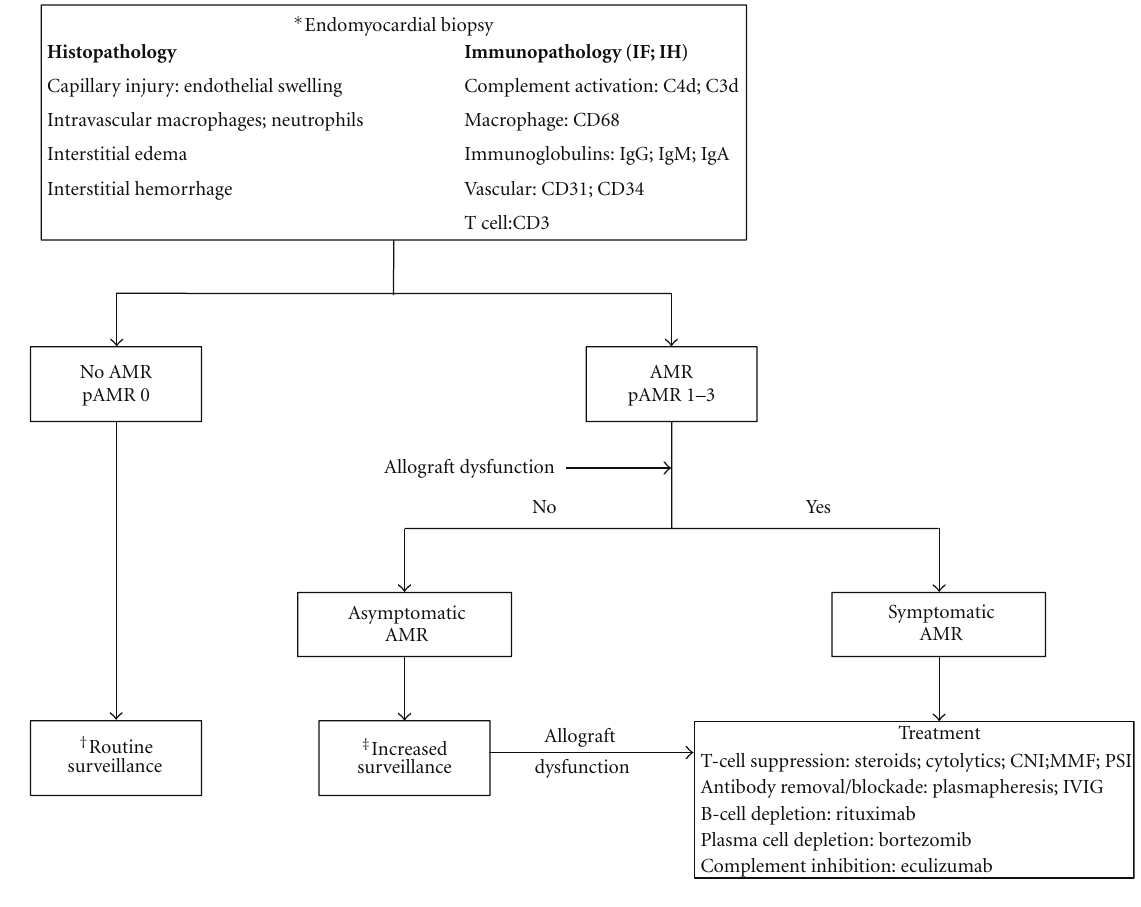
Figure 2: Proposed management algorithm for AMR in heart transplantation. AMR: antibody-mediated rejection, CNI: calcineurin inhibitors, DSA: donor specific antibodies, IF: immunofluorescence, IH: immunohistochemistry, IVIG: intravenous immunoglobulin, MMF: mycophenolate mofetil, pAMR: ISHLT pathologic AMR grade 0–3, and PSI: proliferation signal inhibitor. ∗ Endomyocardial biopsy frequency as per institution protocol. † DSA monitoring at week 2, months 1, 3, 6, and 12 in first year after transplant and annually thereafter. ‡ Assessment of allograft function every month and DSA every 3 months until two negative or unchanged